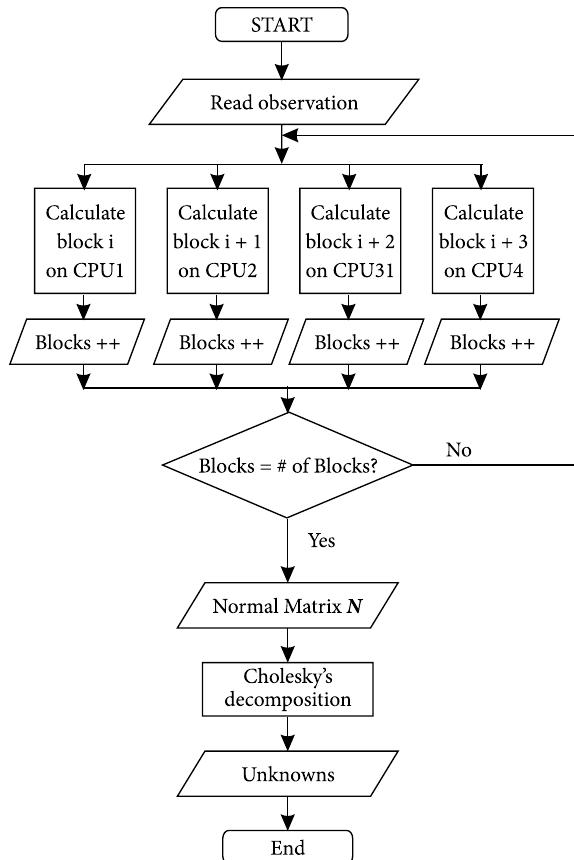
Fig. 1. Flowchart for calculating unknowns using parallel